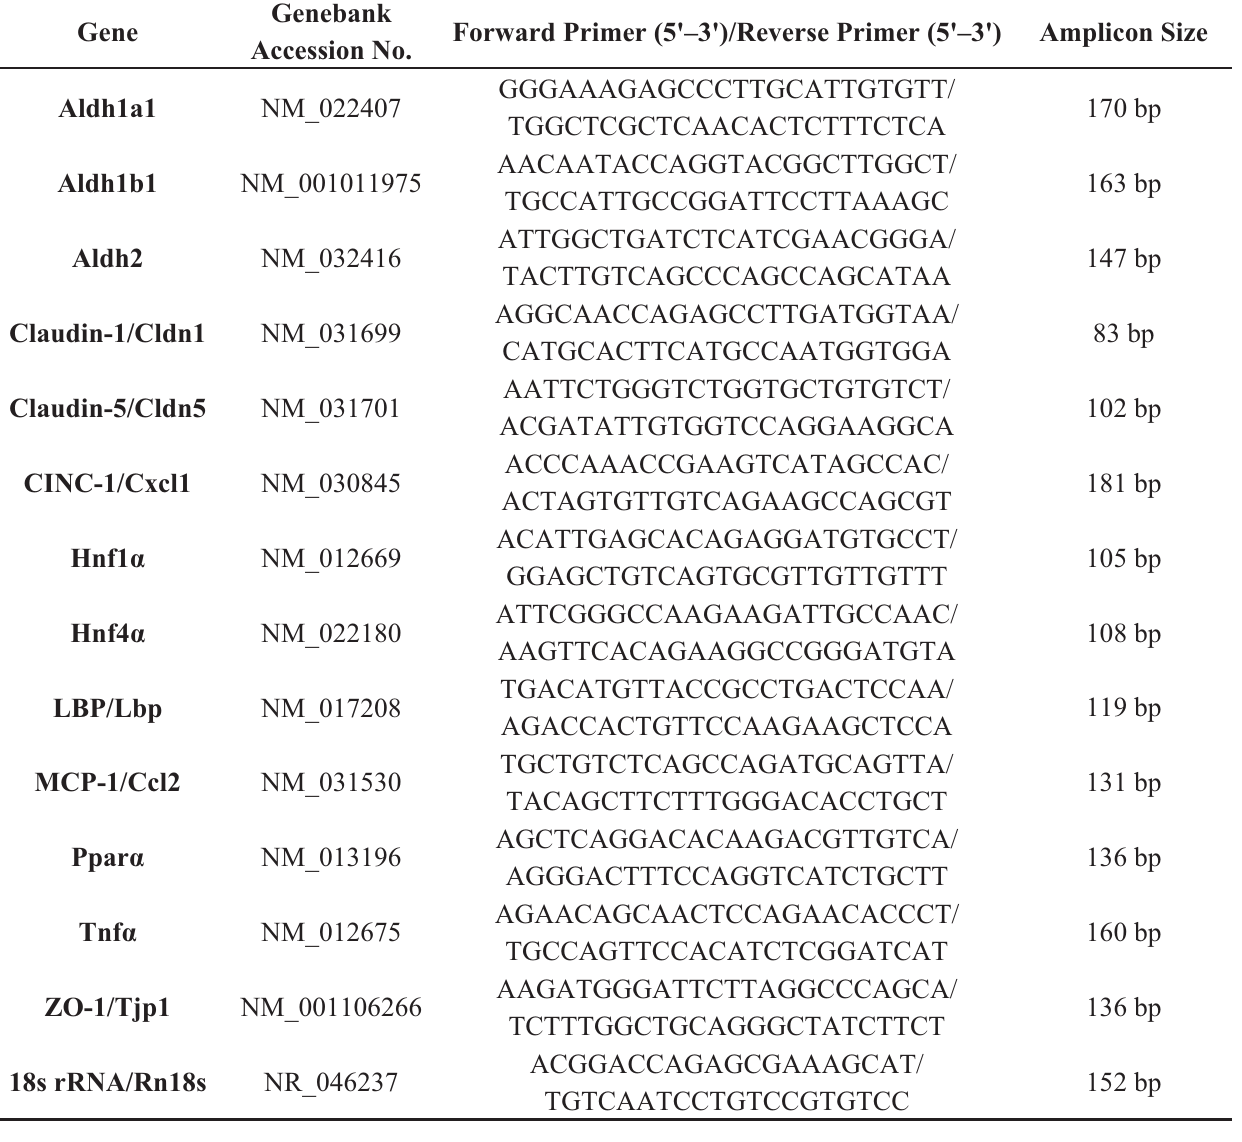
Table 1. Primer sequences used for qPCR